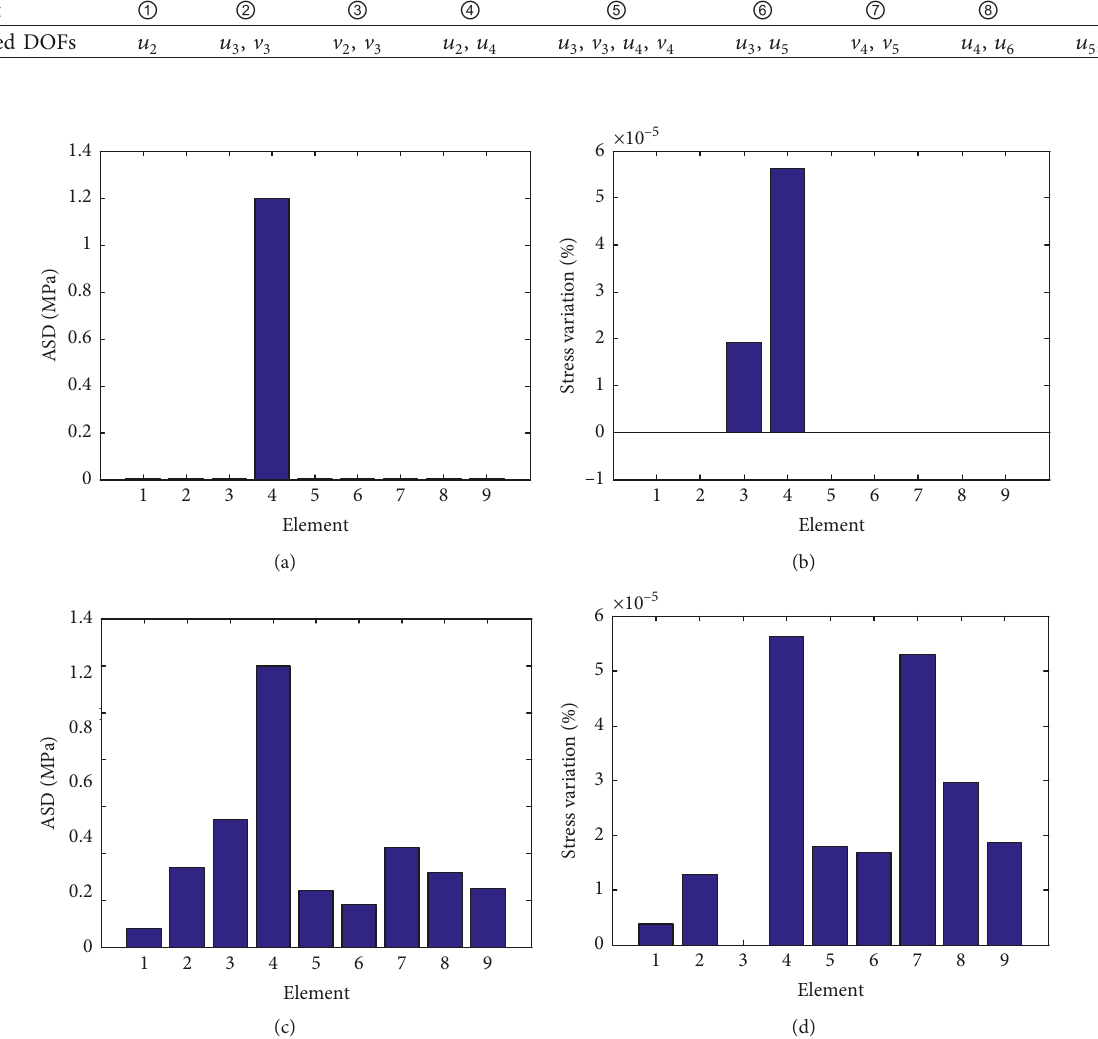
Figure 3: A single damage at element ④ using the global-based approach of (a) ASD of noise-free, (b) stress change rate of noise-free, (c) ASD of 5% noise, and (d) stress change rate of 5%